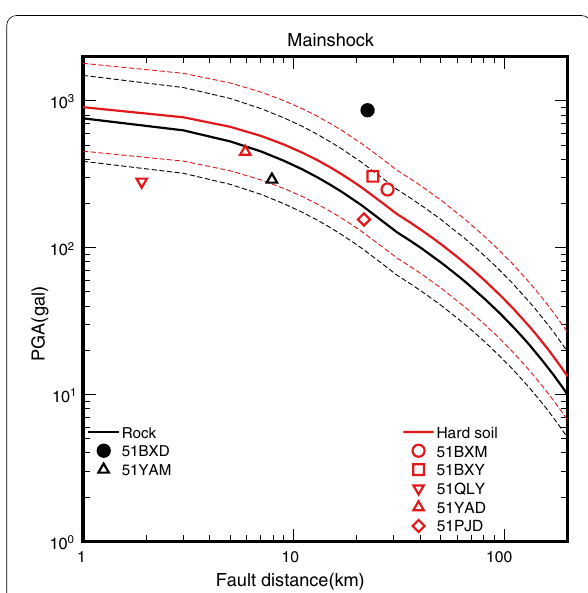
Fig. 8 Ground motion prediction equation (GMPE) for the M w 6.6 earthquake of the shallow crustal earthquakes (Zhao et al. 2016) and observed PGAs at seven target stations of the mainshock. The black and red curves denote the GMPEs of rock sites and hard soil sites, respectively. The black and red dashed lines denote the standard deviations of GMPEs. The fault distance is evaluated as the closest distance between the fault plane and the